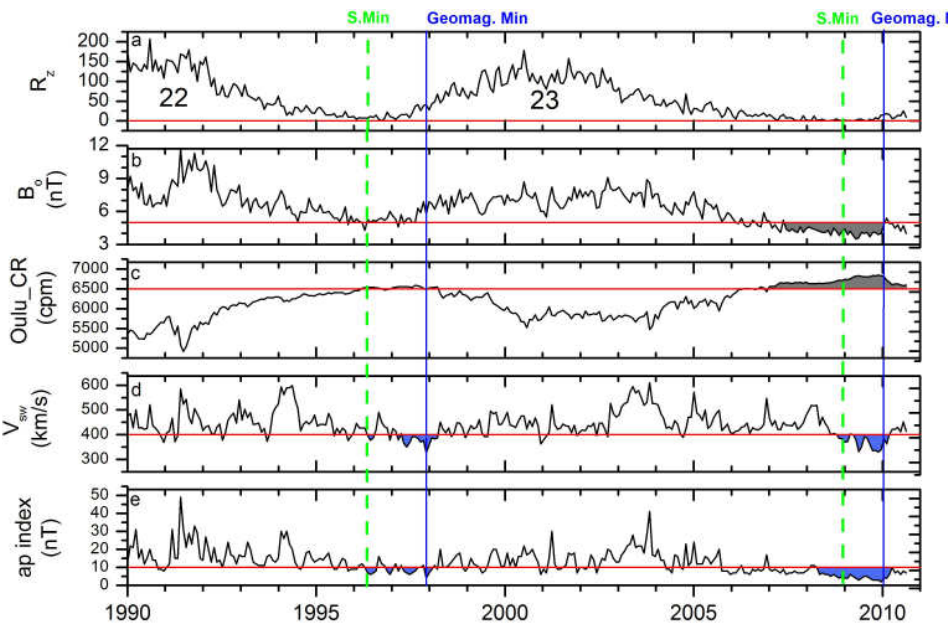
Fig. 1. Solar, interplanetary, cosmic ray and geomagnetic activity data for SC22 and 23. A dashed vertical green line indicates the official sunspot minima. A vertical solid line shows the geomagnetic activity minima on Earth. Horizontal (arbitrary) red lines are shown for R z = 0, B 0 = 5nT, CR=6500cpm, V SW = 400kms − 1 and ap=10nT. The shaded regions in the ap panel are used to define the minimum geomagnetic activity (MGA) intervals, MGA22 and